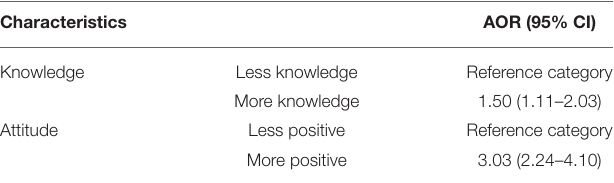
TABLE 3 | Degree of practices based on the participant’s knowledge and attitude.